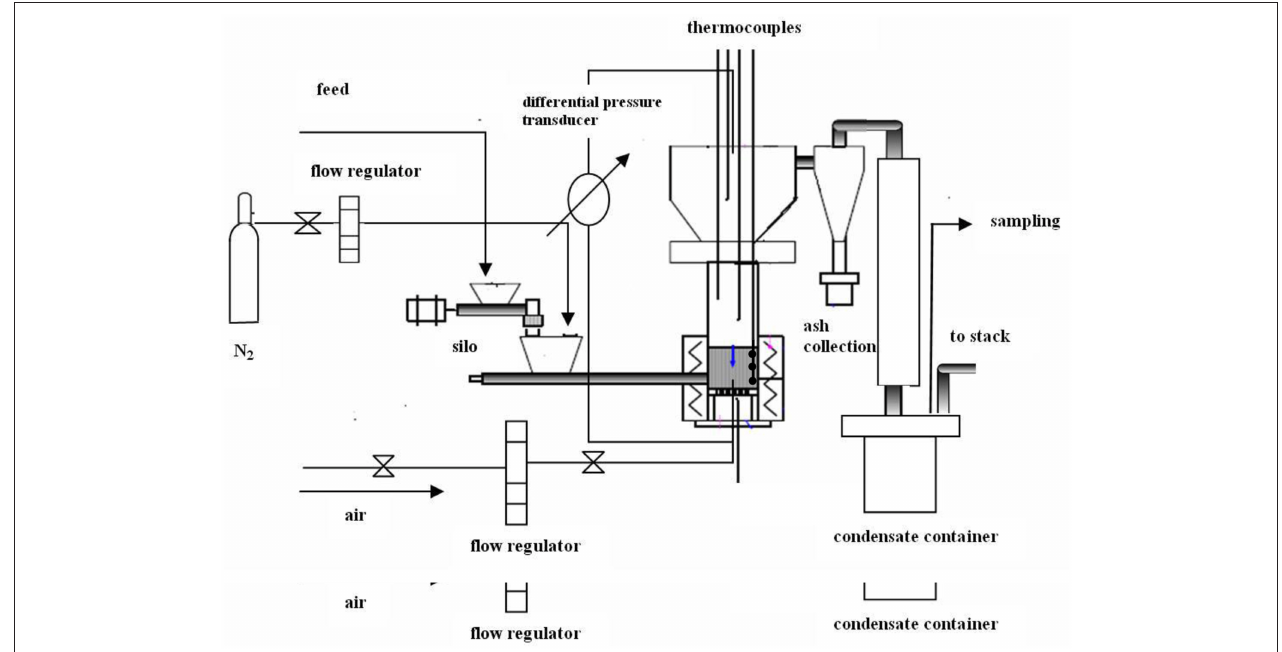
FIGURE 1 | Schematic diagram of the fluidized bed